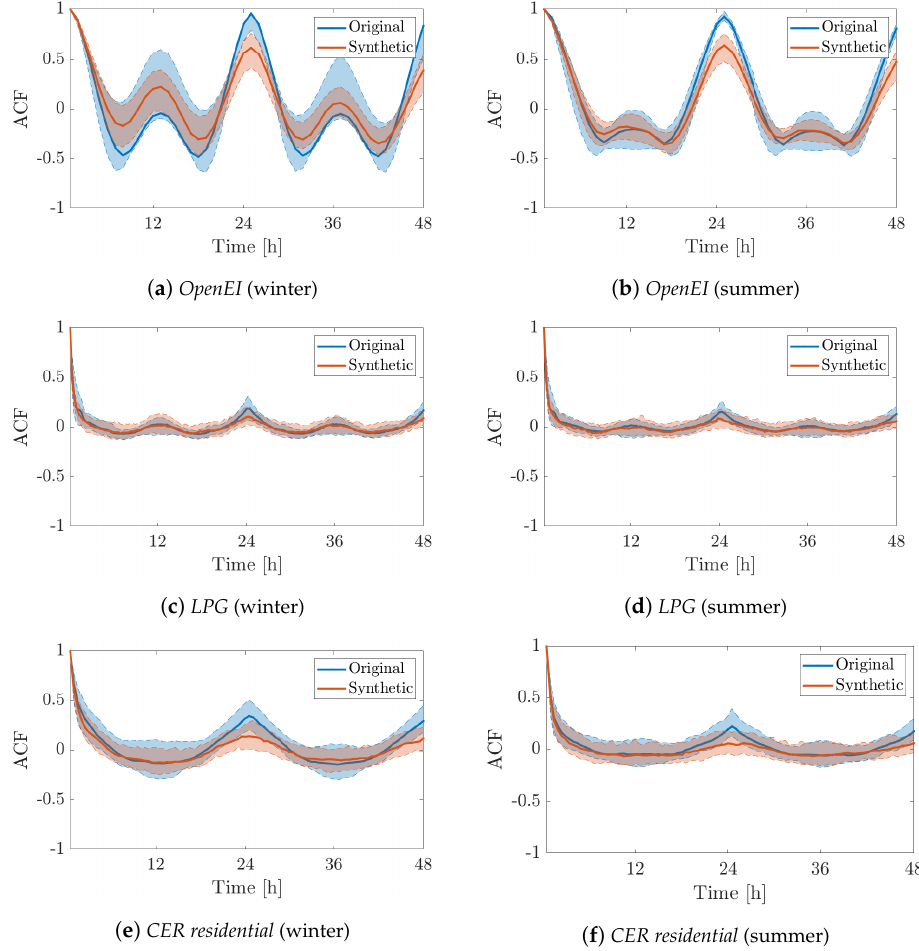
Figure 6. Examples of ACF curves associated with the original LPs and the respective SLPs extracted from the most populated clusters of different data set in winter and summer, respectively. The shaded bands comprise the curves between the 0.5-quantile and the 0.95-quantile of 100 original or synthetic ACFs. The median ACFs are also plotted using thicker